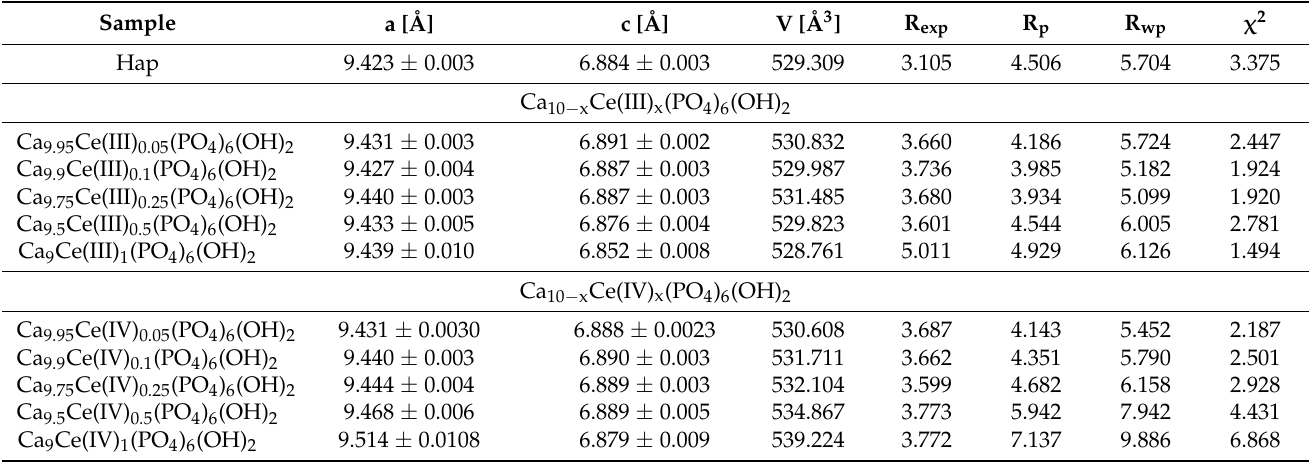
Table 2. Unit cell parameters a, c, V, and the agreement indices for hydroxyapatite cerium (III)-doped hydroxyapatite and cerium (IV)-doped hydroxyapatite with various concentrations.